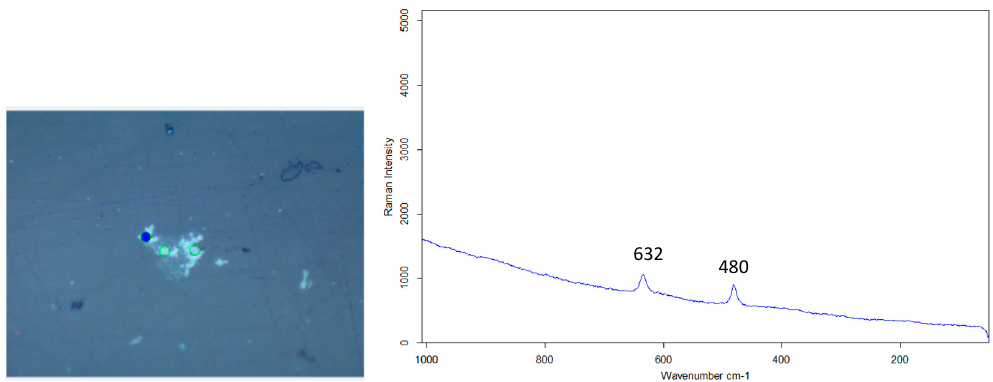
due to the interference of glassy matrix in the measurement; O,Na, Mg, Al, Cl, Ca, and Fe can be attributed to